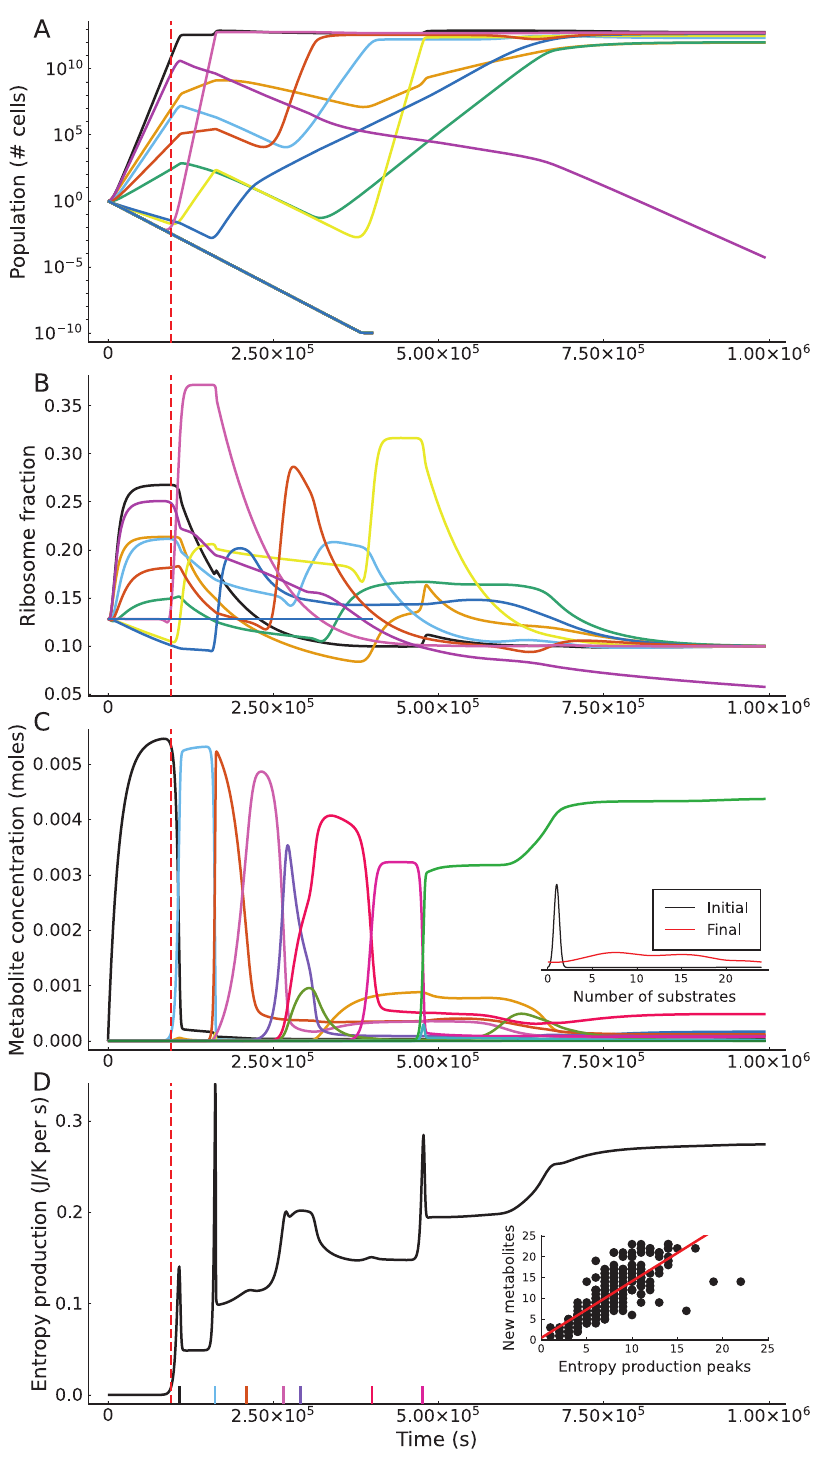
Fig 2. Key dynamical behaviours of the model. The vertical dashed lines in all plots mark the time point where the third metabolite is available in sufficient quantity (1 × 10 − 4 moles) to support growth. This specific simulation is started with an initial community of 250 species, each of which is assigned between 1 and 5 reactions from a 25 metabolite (47 reaction) network. The parameter set used here was one of the 250 parameter sets generated using a reversible kinetic scheme and a total free-energy change of 5.0 × 10 6 J mol − 1 . A : Microbial population dynamics. B : Ribosome